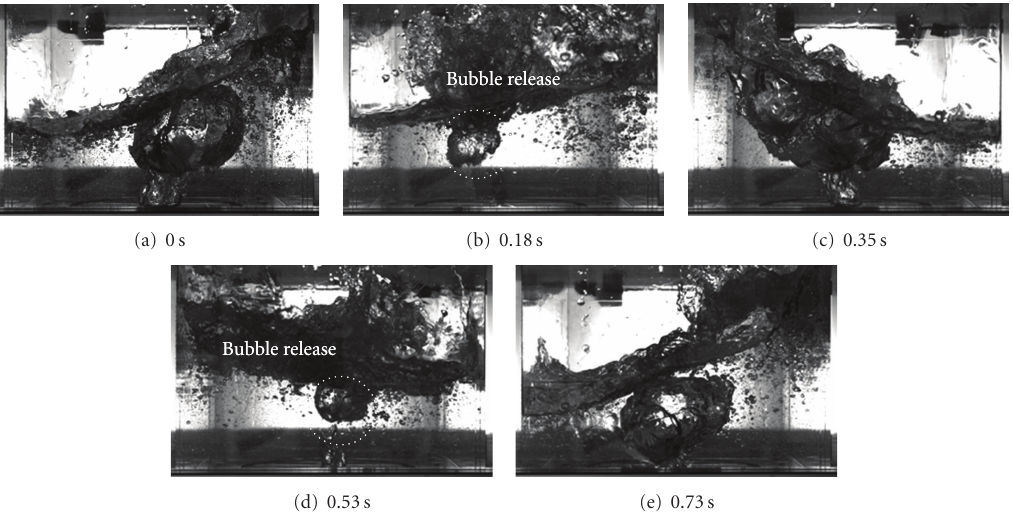
Figure 9: First-mode sloshing in the rectangular tank ( J G = 7 . 7m/s, J G ∗ 1 / 2 = 0 . 70, Ku G 1 / 2 = 1 . 3, and D = 30 mm).